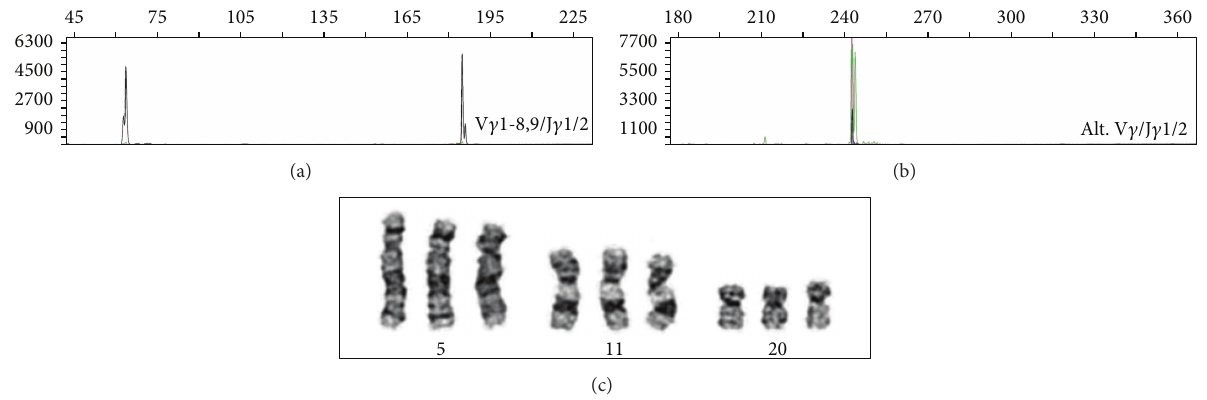
Figure 3: Molecular and cytogenetics findings in the bone marrow. (a) and (b) Assessment of TCR gamma receptor gene rearrangement by PCR on formalin-fixed, paraffin-embedded tissue sections from bone marrow clot demonstrated biclonal PCR product using V 𝛾 1-8,9/J 𝛾 1/2 primer set (a) and monoclonal PCR product using Alt. V 𝛾 /J 𝛾 1/2 primer sets (b). (c) G-band karyotypic study on bone marrow aspirate demonstrated an abnormal karyotype in all 20 dividing cells examined: 49,XY,+5,+11,+20/ [20]